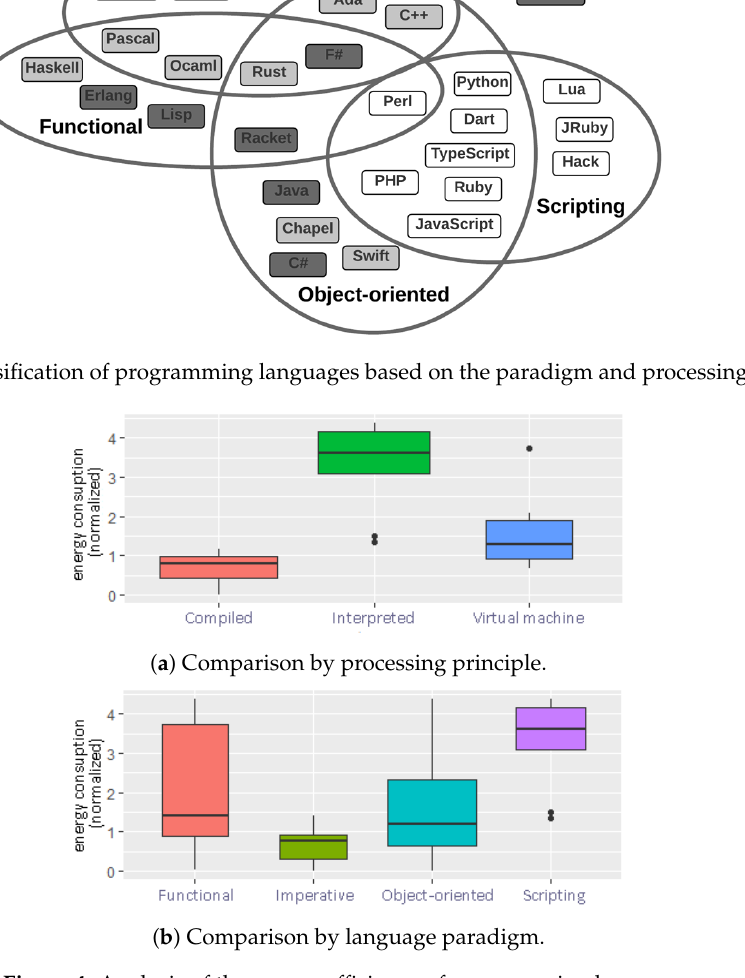
( b ) Comparison by language paradigm. Figure 4. Analysis of the energy efficiency of programming